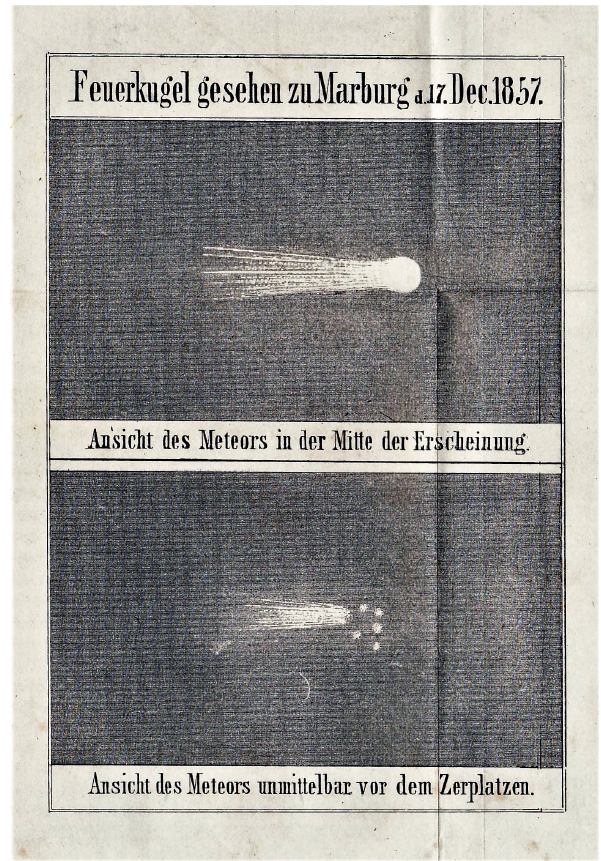
Figure 7. The two phases of the fireball observed on 17 December 1857 at Marburg (Heis, 1858; plate